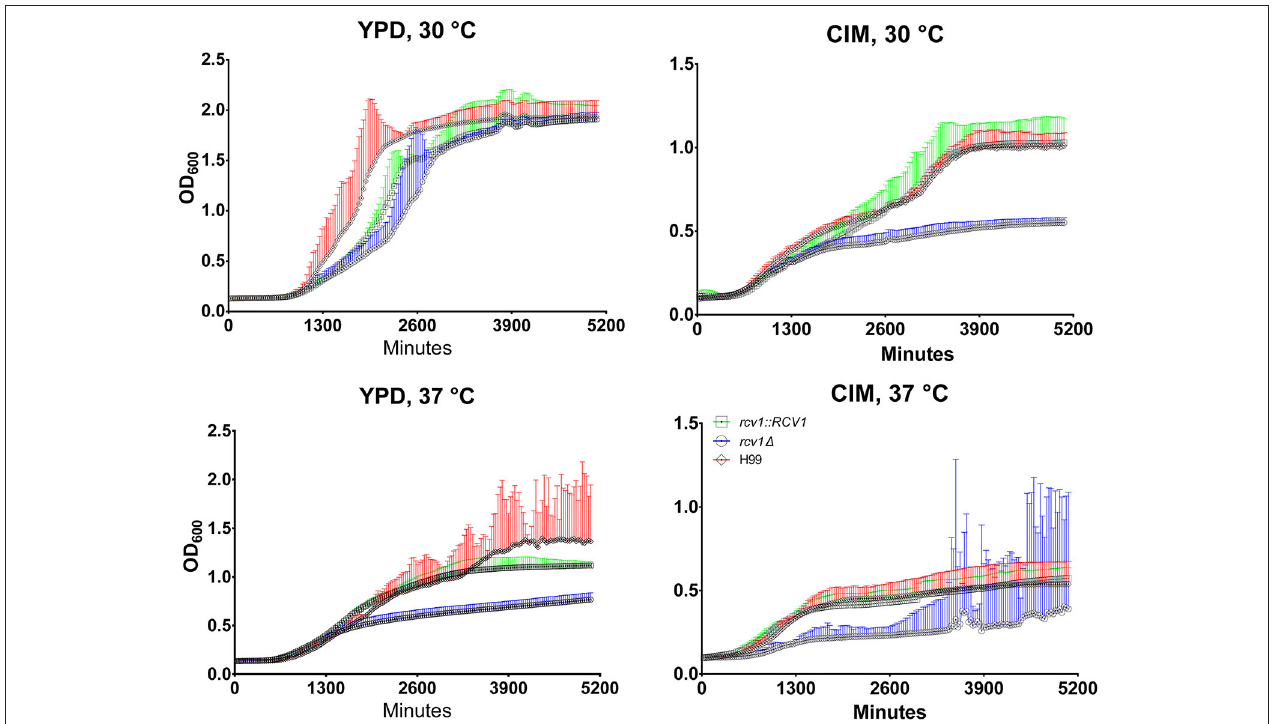
FIGURE 4 | At 37 ◦ C or on cell culture medium, the rcv1 ∆ mutant shows retarded growth and reaches stationary phase at lower densities. C. neoformans yeast cells were inoculated in triplicate at a density of 10 4 cells/mL and incubated at the indicated media and temperatures under orbital shaking and cultures had their OD 600 measured every 30min. The high dispersion in measurements observed at later time points for the mutant strain on CIM at 37 ◦ C was caused by heavy clumping of cells. The experiment is representative of two and each sample was processed in triplicate. Error bars are 95% confidence intervals (CI95%) and the same color of the curves (red, H99; blue, rcv1 ∆ ; green, rcv1 + RCV1